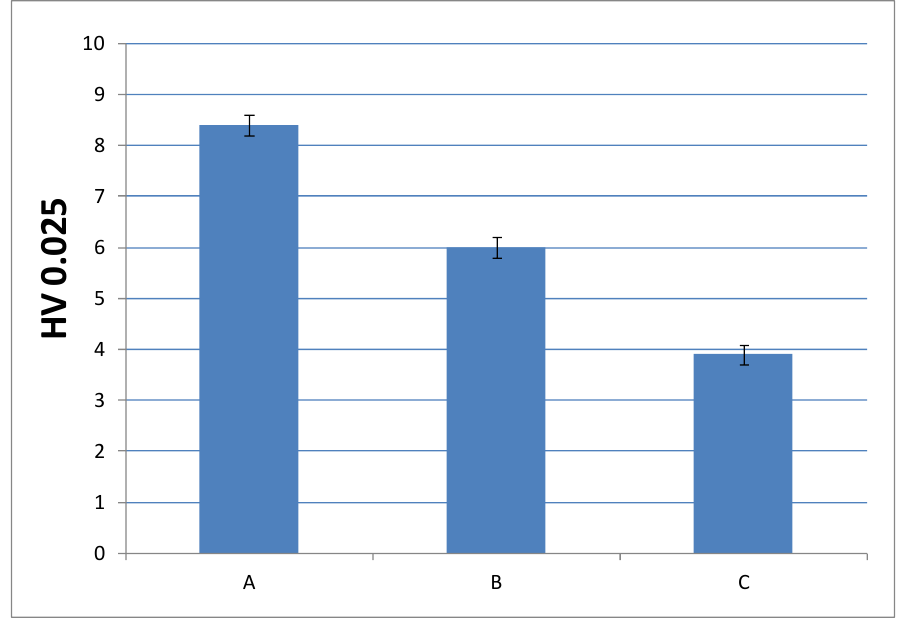
Figure 10. Microindentation hardness (HV) of cured materials prepared from liquid formulations with 1% of DMT amount.